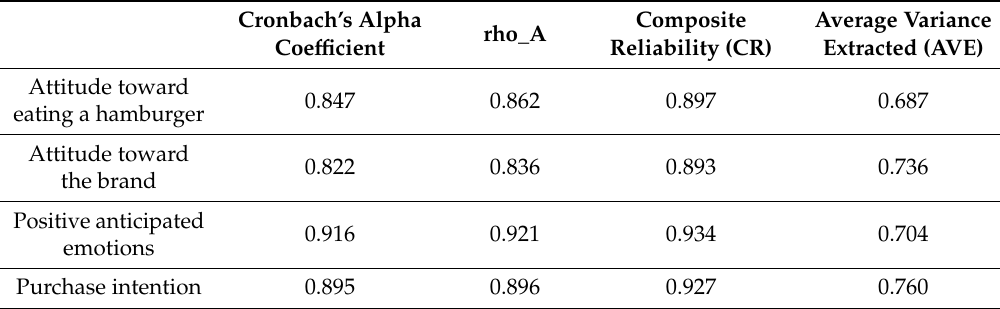
Table 3. Validity Testing.